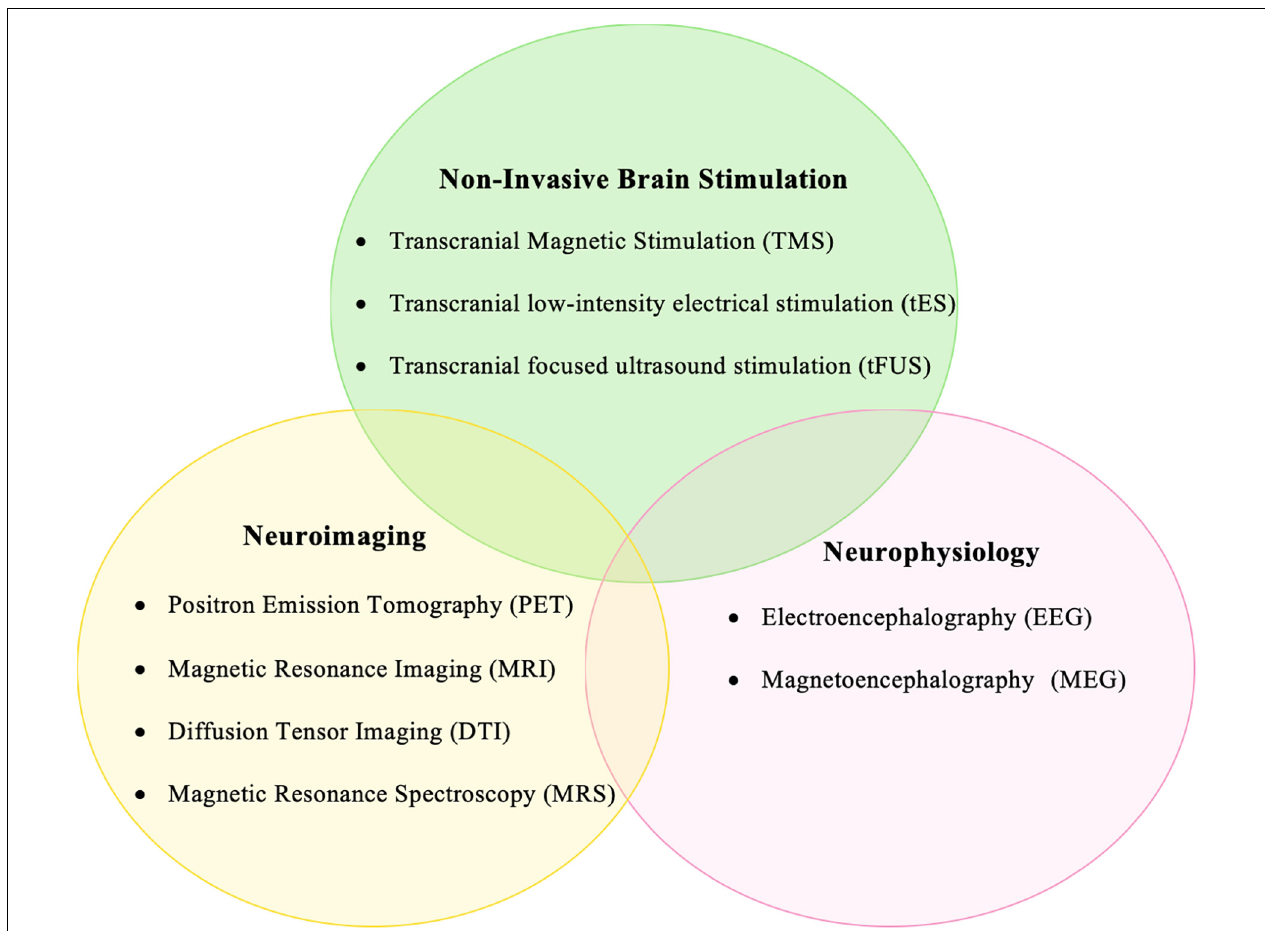
FIGURE 1 | Diagram showing the different non-invasive brain stimulation, neuroimaging, and neurophysiological techniques that can be integrated to investigate the pathophysiology of movement